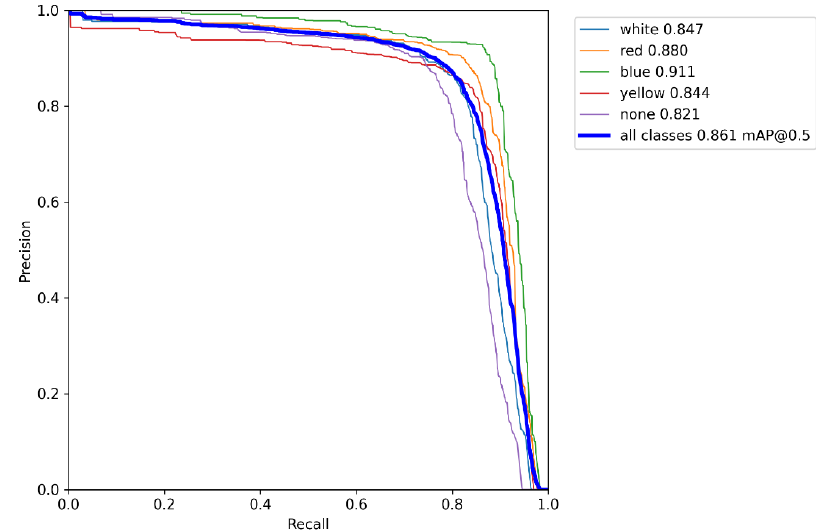
Figure 5. Precision and recall curve of Yolo-v5 model.